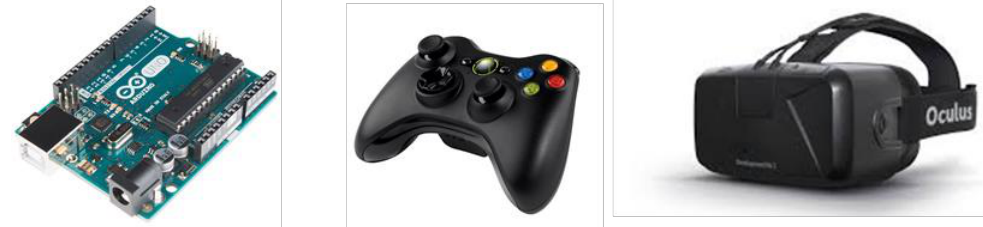
Figure 7. Hardware (input devices and output device): Arduino UNO R3, Microsoft Xbox 360, and Oculus VR DK2 from left to right.